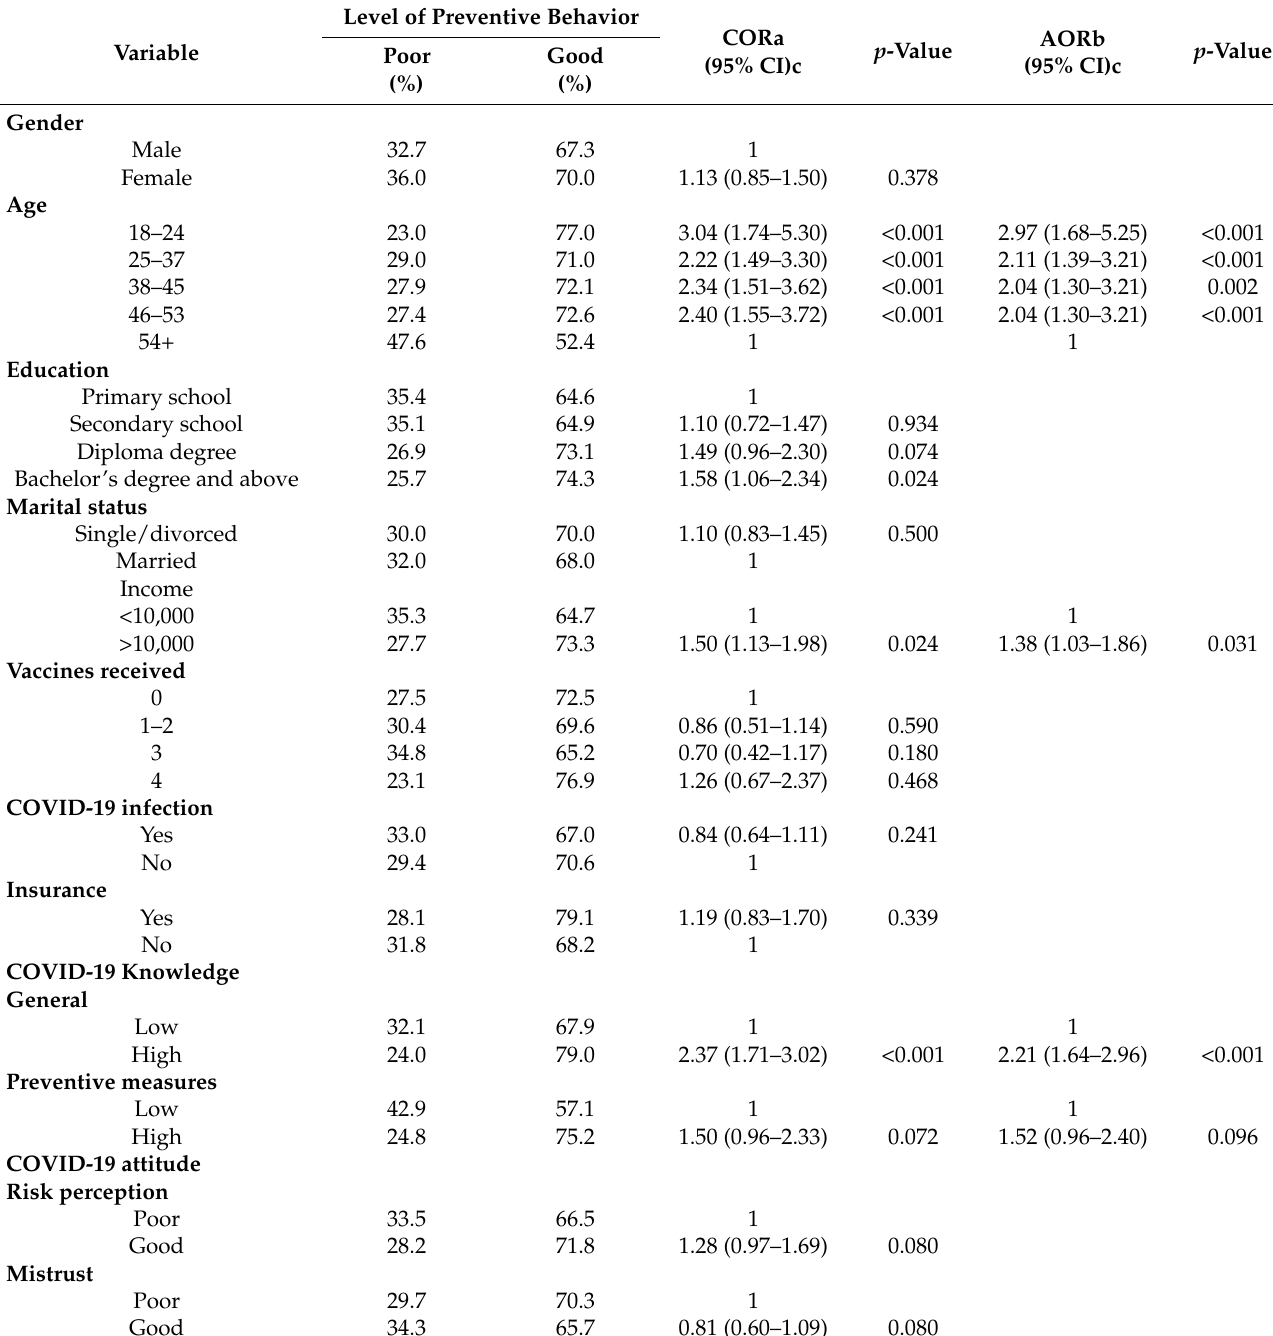
Table 6. Association between factors and good preventive behaviors for COVID-19 prevention by multiple logistic